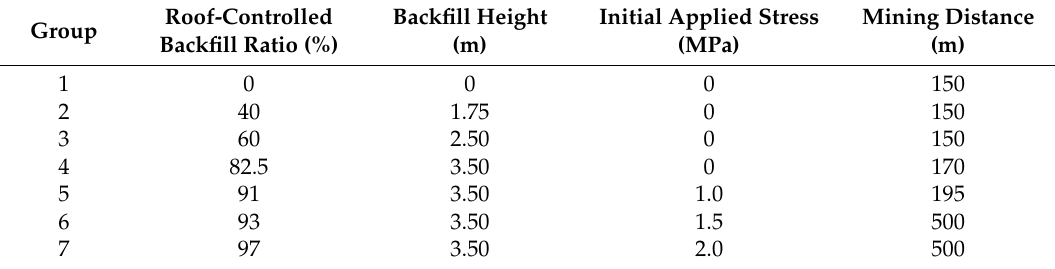
Table 2. Simulation schemes in different backfill ratios.